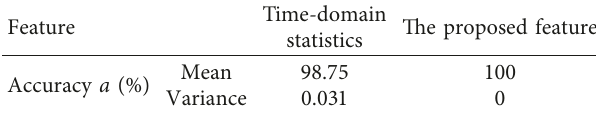
Table 3: RBF recognition results based on different features.